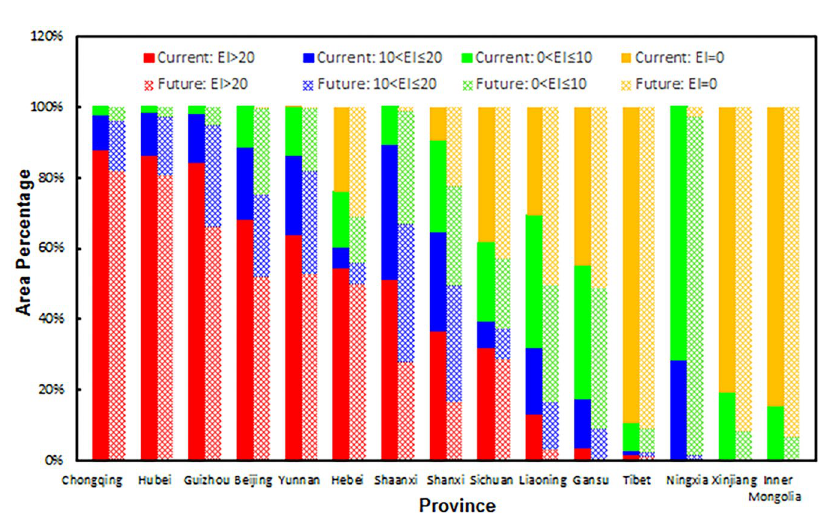
Figure 6. Area changes of different ranges of EI value in different provinces for Euwallacea fornicates under the current and future conditions. Almost all the area of Anhui, Fujian, Guangdong, Guangxi, Hainan, Henan, Hongkong, Hunan, Jiangsu, Jiangxi, Shandong, Shanghai, Tianjin and Zhejiang are highly favourable habitats, and all the area of Jilin, Qinghai and Heilongjiang are unfavourable habitats, therefore, these provinces weren’t illustrated in the